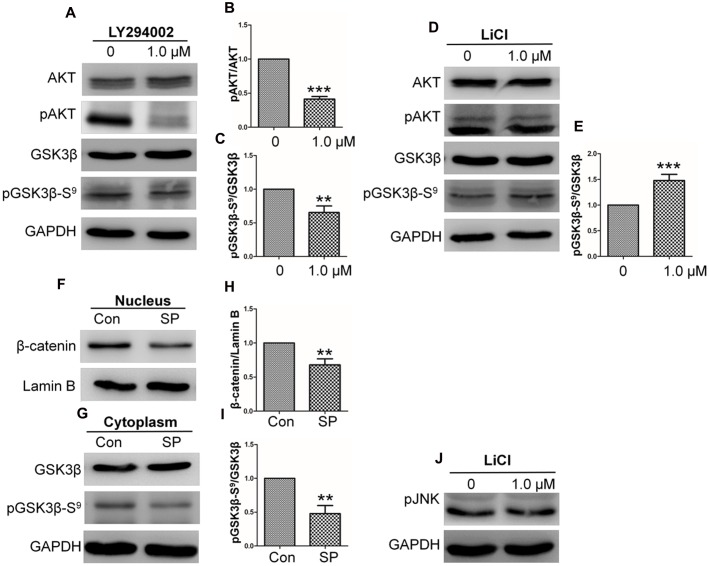
Basic fibroblast growth factor activates the GSK3β/β-catenin/WNT signaling pathway via the PI3K/JNK pathway. Human skin fibroblasts were treated for 1 h with the specific PI3K inhibitor, Ly294002 (1.0 μM), the GSK3β inhibitor, LiCl (1.0 μM), or solvent control. (A) Total cell lysates were then prepared and analyzed via Western blotting. Akt Ser473 and GSK3β Ser9 phosphorylation levels were blocked by Ly294002. (D) GSK3β Ser9 phosphorylation was increased by treatment with LiCl. (F) Nuclear β-catenin levels were increased by treatment with the JNK inhibitor, SP600125. (G) Phosphorylation levels of GSK3β at Ser9 were reduced by treatment with SP600125 for 1 h. (J) JNK phosphorylation was unchanged by LiCl treatment. Densitometry was performed on 3–4 Western blots (each representative of an independent experiment) per condition. Densitometry data for pAKT (B) or pGSK3β Ser9
(C) from the blots shown in (A) were normalized to those of AKT or GSK3β. Densitometry data for pGSK3β Ser9
(E) from the blot shown in (D) were normalized to those of GSK3β. Densitometry data for nuclear β-catenin (H) from the blot shown in (F) were normalized to those of Lamin B. Densitometry data for pGSK3β Ser9
(I) from the blot shown in (F) were normalized to those of GSK3β. The results are presented as fold changes relative to control fibroblasts grown in 5.5 mM glucose-containing DMEM. Data represent mean values ± the SE (n = 5 independent experiments; ∗P < 0.05, ∗∗P < 0.01, ∗∗∗P < 0.001; Student’s t-test). Con, control.